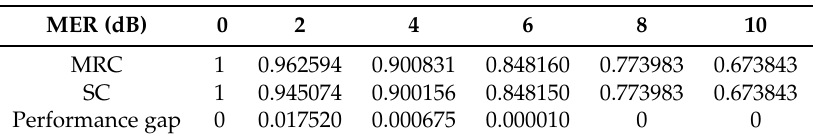
Table 1. The differences of the secrecy outage probability with the eavesdropper using the maximal ratio combining (MRC) and selection combining (SC)